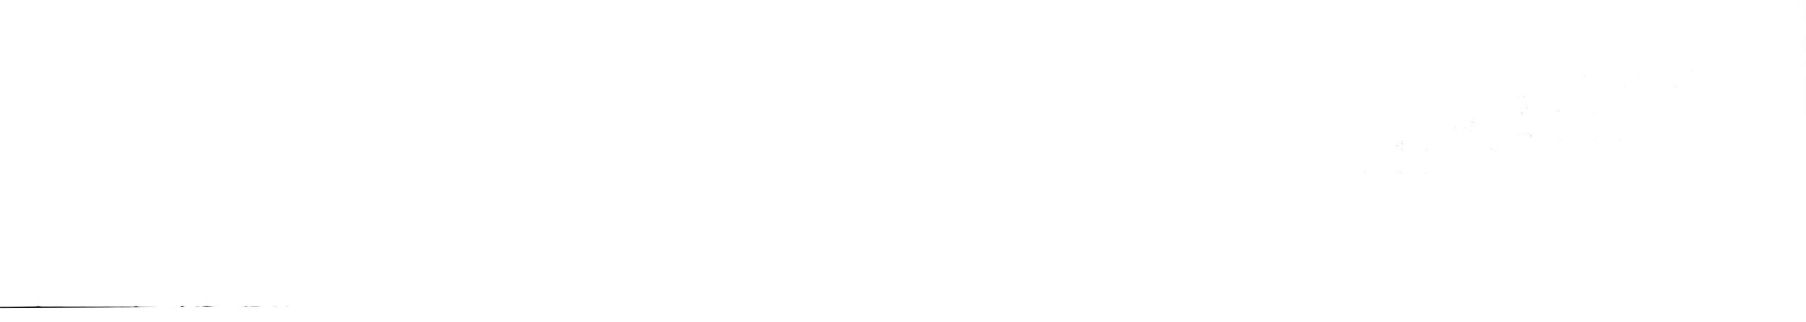
Table II. - Measurements Irom T. sabanensis n. sp. (after Pariselle el at, 2001a); T. phuongi phuongi n. sub-sp.; T. phuongi indonesiensis n. sub-sp. and T. phuongi malaysiensis n.